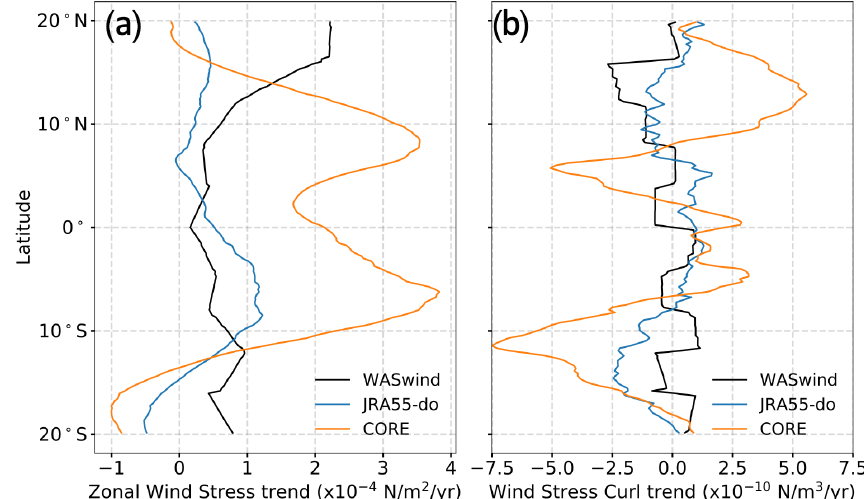
Figure 12. The zonal mean during the 1958–2007 period for (a) zonal wind stress trend and (b) wind stress curl trend over the tropical Pacific